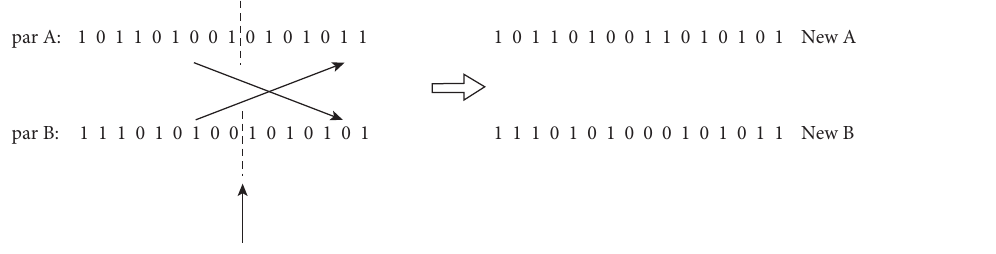
Figure 2: The two parameters sets A and B exchange the part after the cross point and reconstitute two new parameters